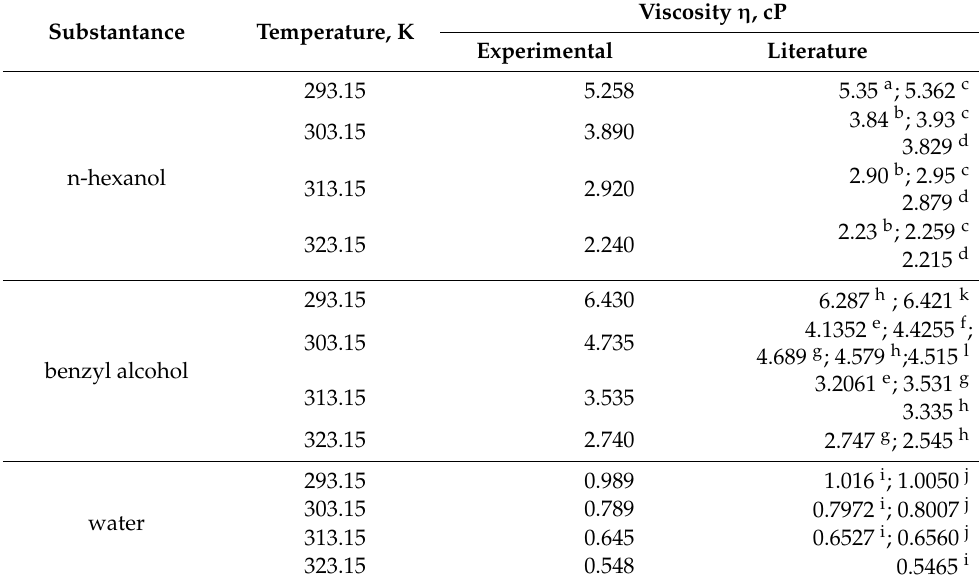
Table 1. Viscosity of pure compounds (n-hexanol, benzyl alcohol, water) determined experimentally.